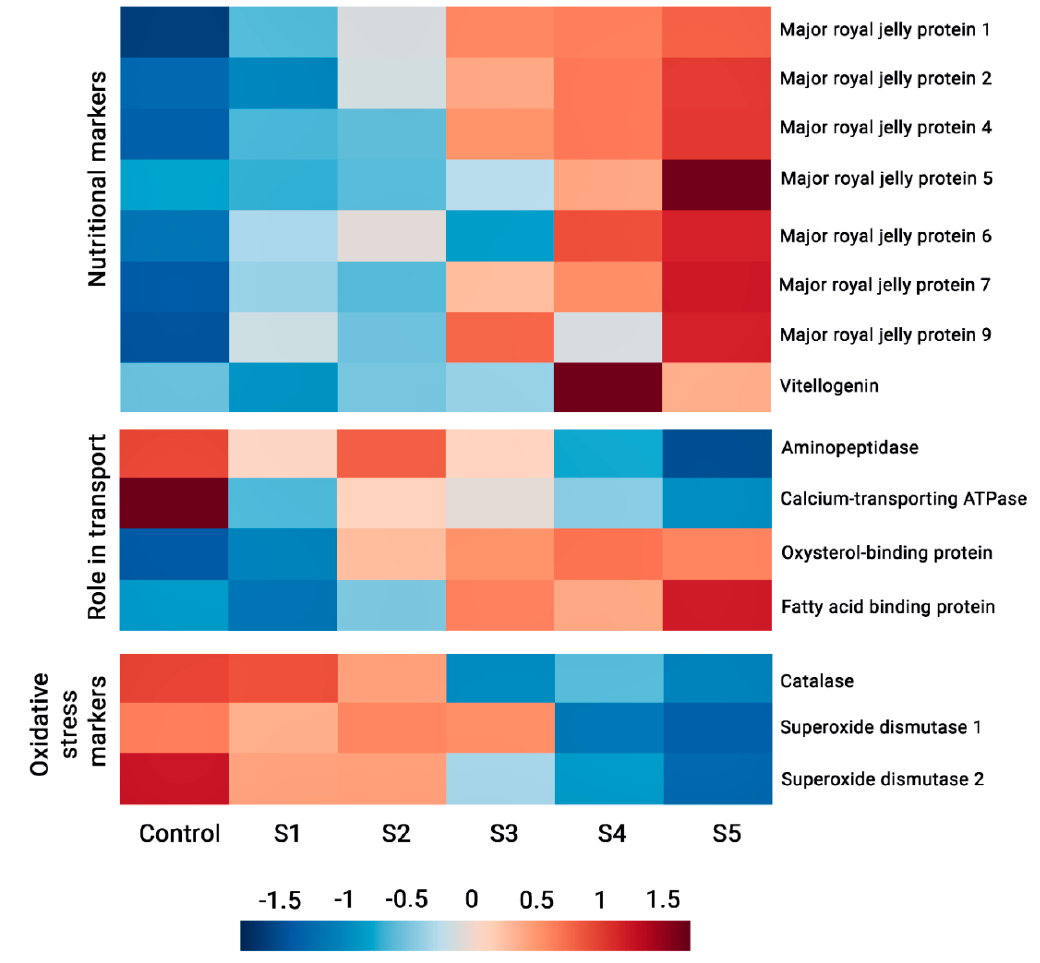
Figure 4. Heat map shows the mean relative abundances of the selected 15 proteins across all treatment groups. S1–S5 indicate dietary groups treated with 0.1%, 0.25%, 0.5%, 0.75% and 1.0% dry diet weight of 24-methylenecholesterol respectively.